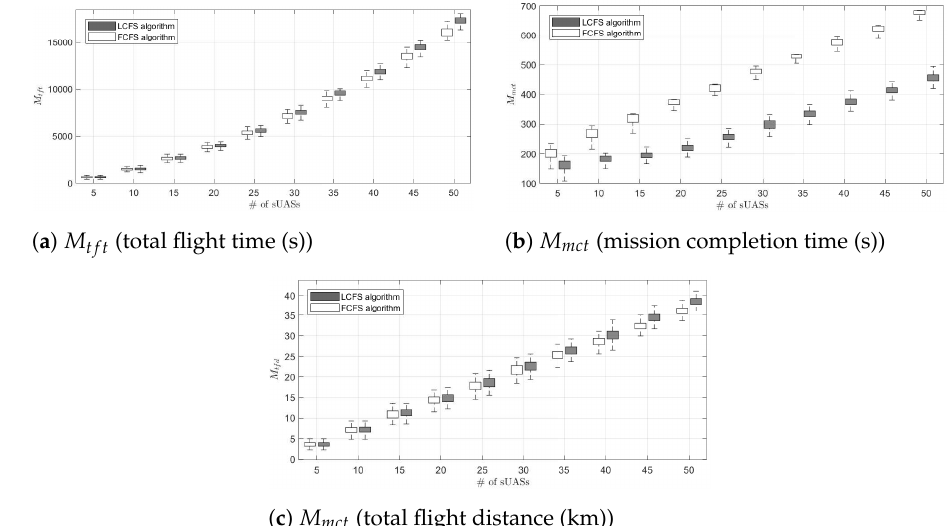
Figure 10. 1-to- M Case: Standard deviation comparisons between the FCFS algorithm and the LCFS algorithm for M tft , M mct , and M tfd